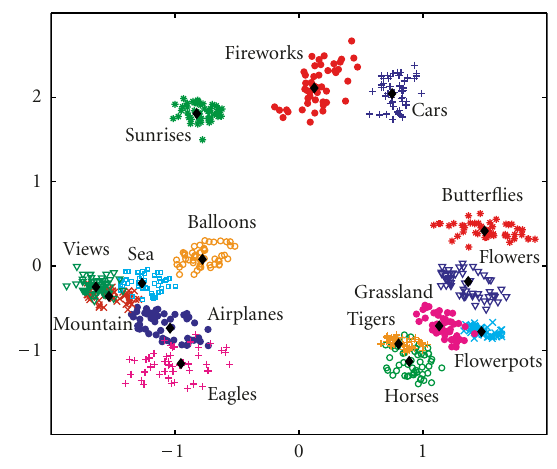
Figure 6: Perceptual organization of the entire database based on the e ffi cient approximation facilitated via the appending technique.